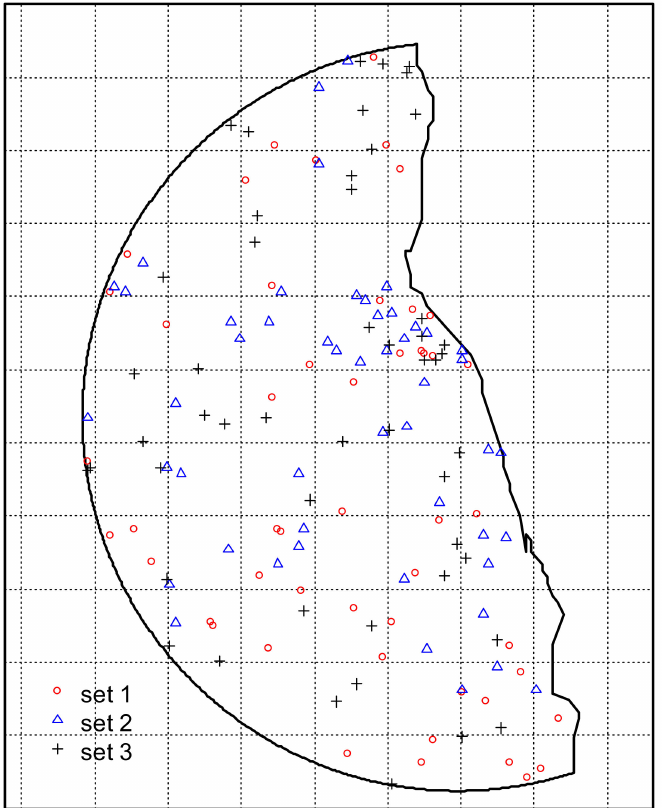
Figure 3. Distribution of 3 sets of 50 rain gauge locations selected by the stratified sampling